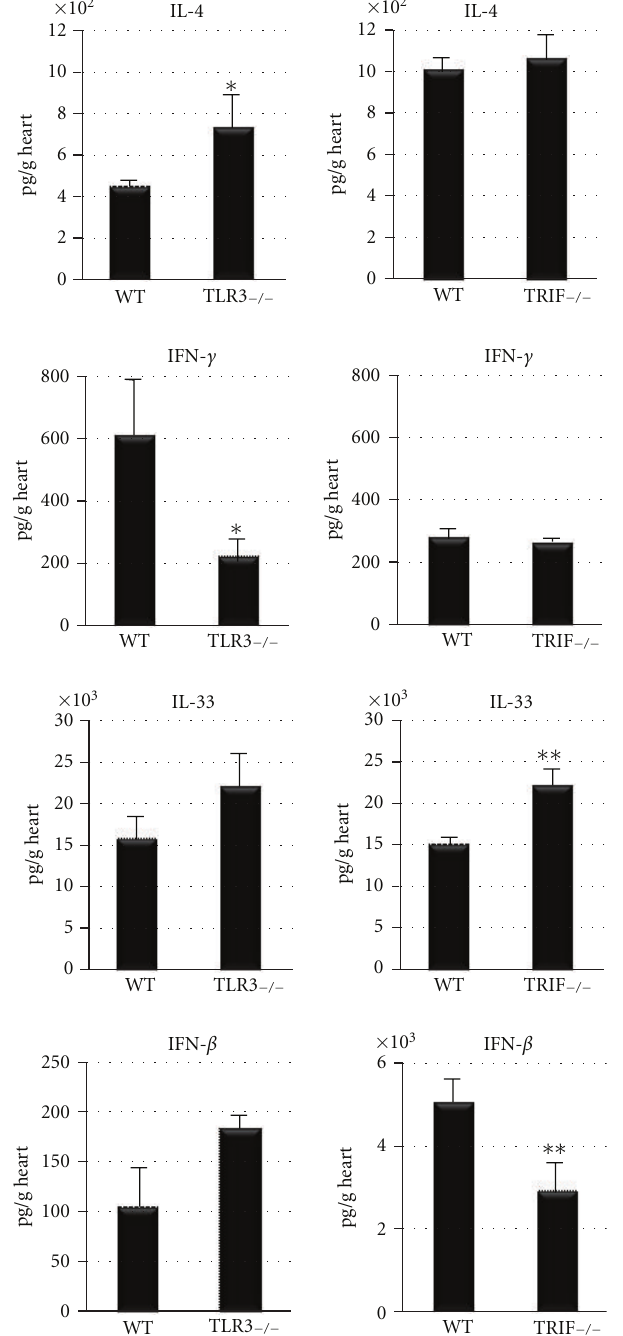
Figure 6: TLR3-deficient (TLR3 − / − ) mice have reduced IFN- γ and elevated IL-4 levels in the heart compared to WT B6.129 controls, while TRIF − / − mice have reduced IFN- β and increased IL-33 com-pared to WT BL/6 mice by ELISA. Similar results were obtained in at least three separate experiments and show the mean ± SEM of 7 to 12 mice/group. ∗ : P < 0 . 05; ∗∗ : P < 0 . 01.